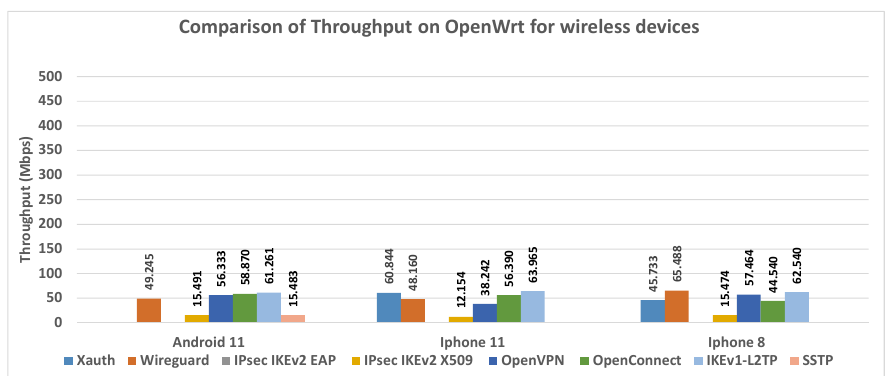
Figure 26. Throughputs data collected during the VPN connection tests with wireless